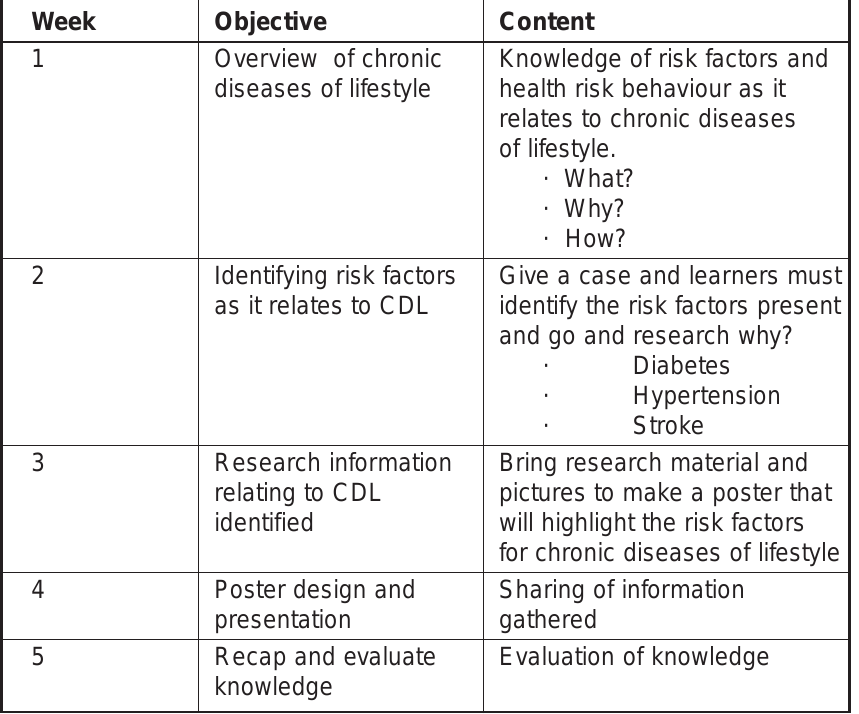
Table 1: Outline of the health education